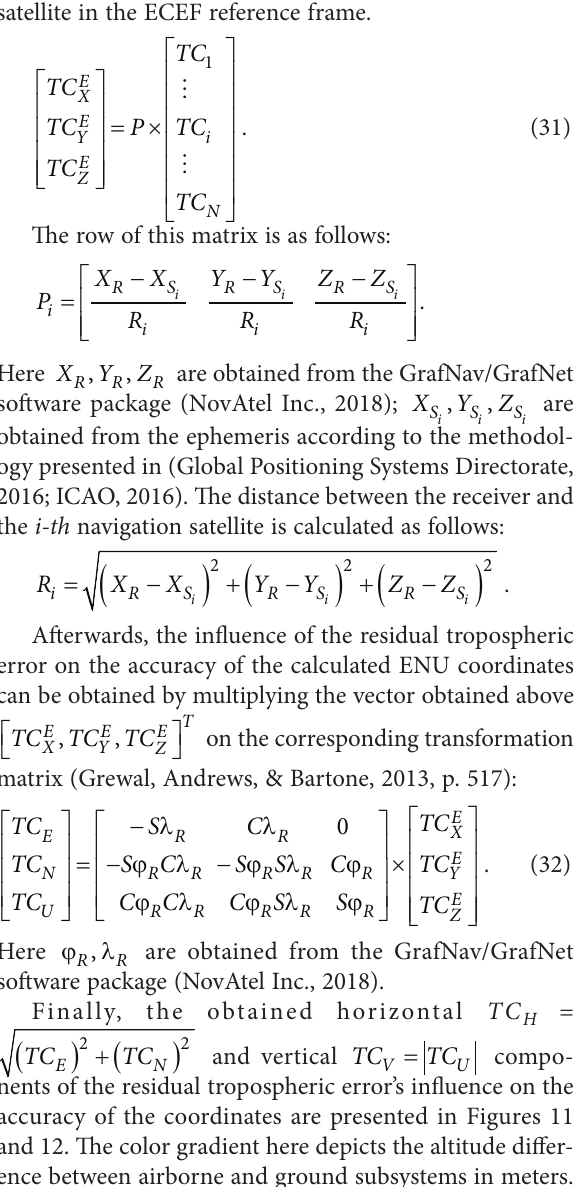
Figure 11. Horizontal component of the residual tropospheric error’s influence on coordinate determination